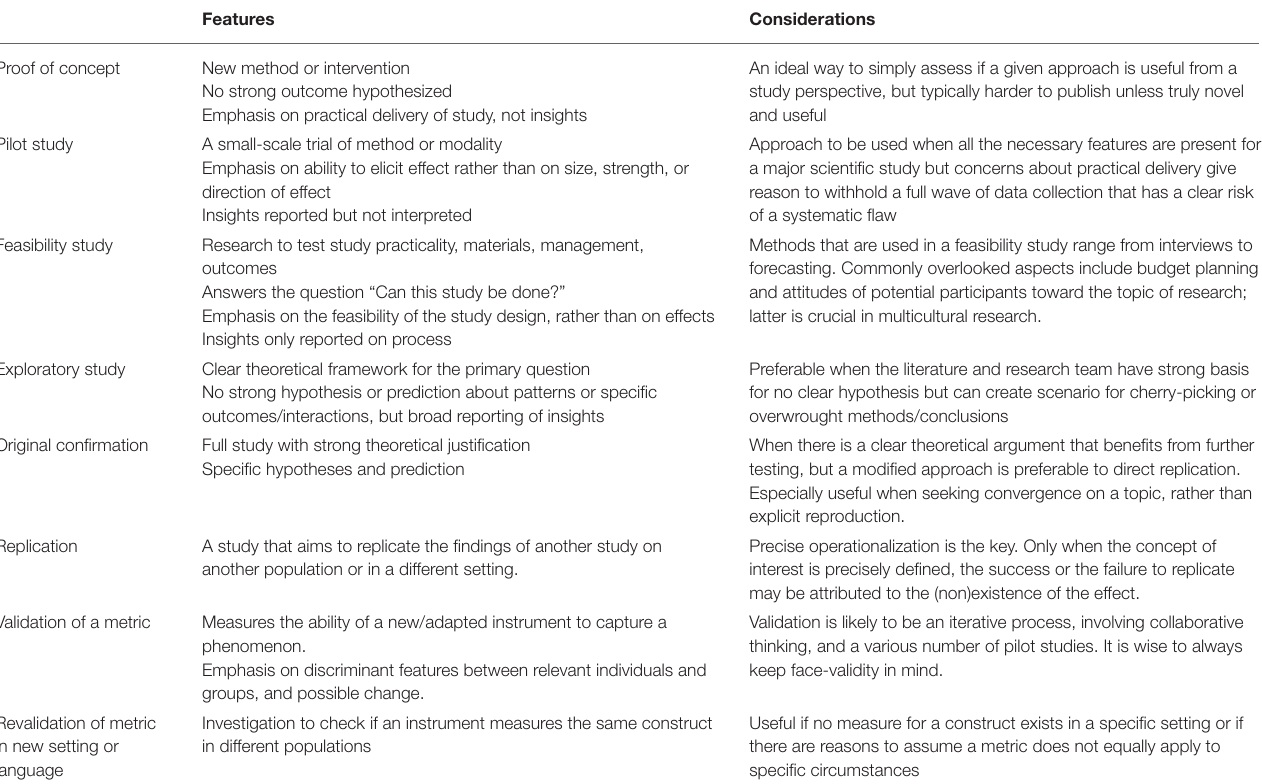
TABLE 1 | List of common study designs for early career